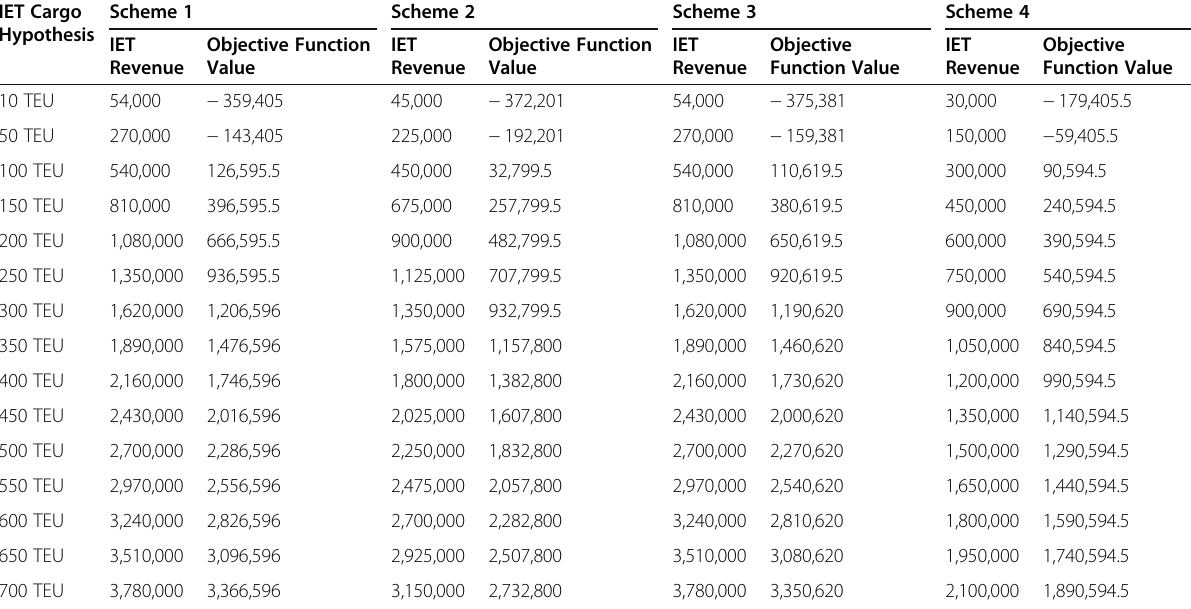
Table 10 Objective Function Value of Scheme 2 under Different IET Revenue Hypothesis (Source: authors) IET Cargo Scheme 1 Scheme 2 Scheme 3 Scheme 4 Hypothesis IET Objective Function Revenue